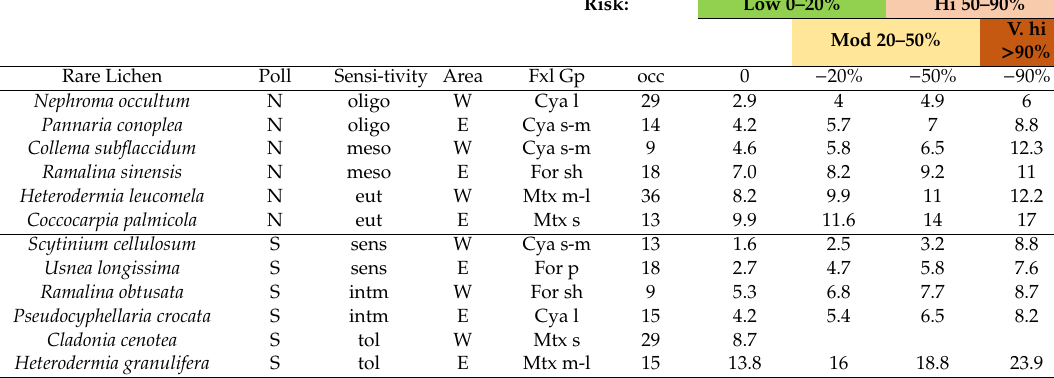
Table 5. Deposition (kg ha − 1 y − 1 ) associated with 0, 20%, 50% and 90% declines in species occurrences can be used to quantify the risk of extirpation for rare species from eutrophying or acidifying air pollutants. Species of rare lichens were randomly selected from the national dataset to represent each pollutant (Poll), sensitivity class (Sensitivity), area, and functional group (Fxl Gp). The last four column headings are the percentage decrease from maximum detection frequency from Table S2 in [19]; values are deposition in kg ha − 1 yr − 1 . Risk of extirpation is proposed as low at deposition levels associated with declines of 0–20%, moderate from 20–50%, high from 50–90% and very high for declines over 90%. Abbreviations: Oligo = oligotroph, meso = mesotroph, eut = eutroph, sens = sensitive, intm = intermediate, tol = tolerant, occ = occurrences, i.e. The number of times species was detected in the Area. E = eastern US (2156 survey sites), W = western US (6699 survey sites). Fxl Gp abbreviations as in Figure